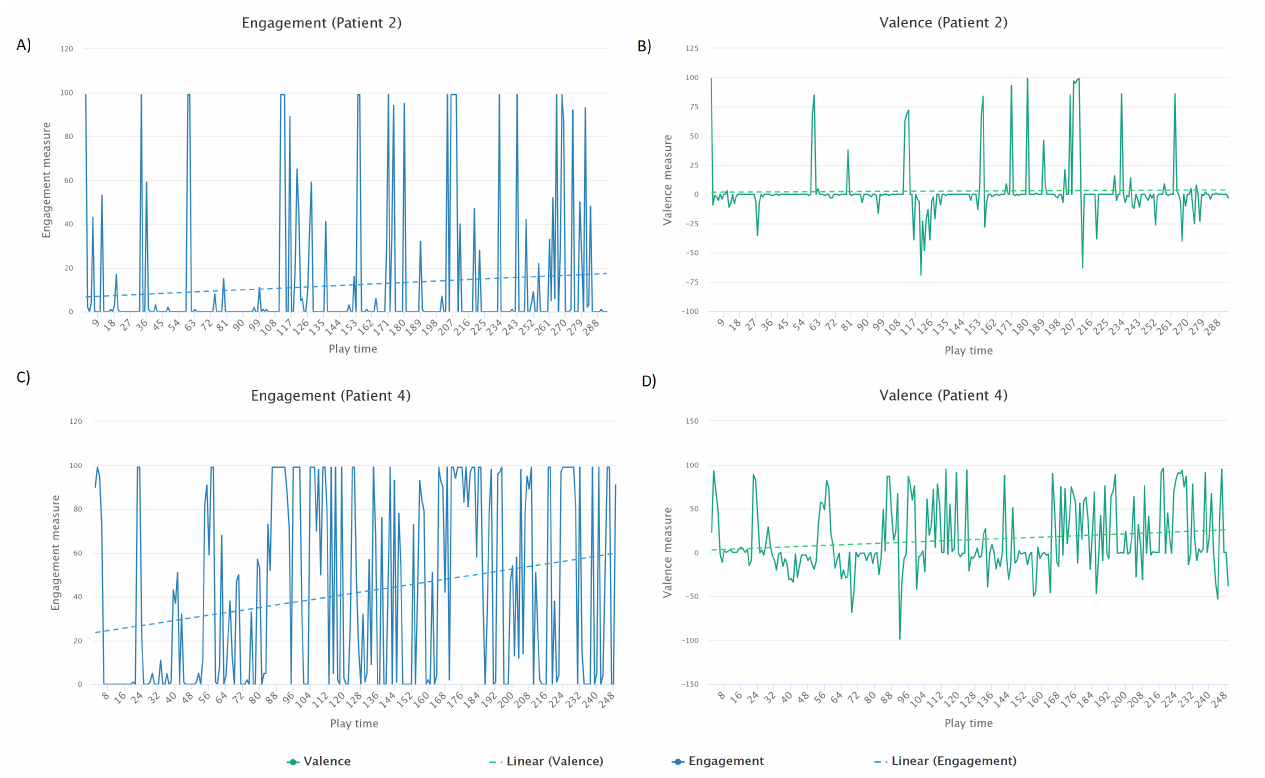
Figure 13: Engagement and valence values for patients 2 and